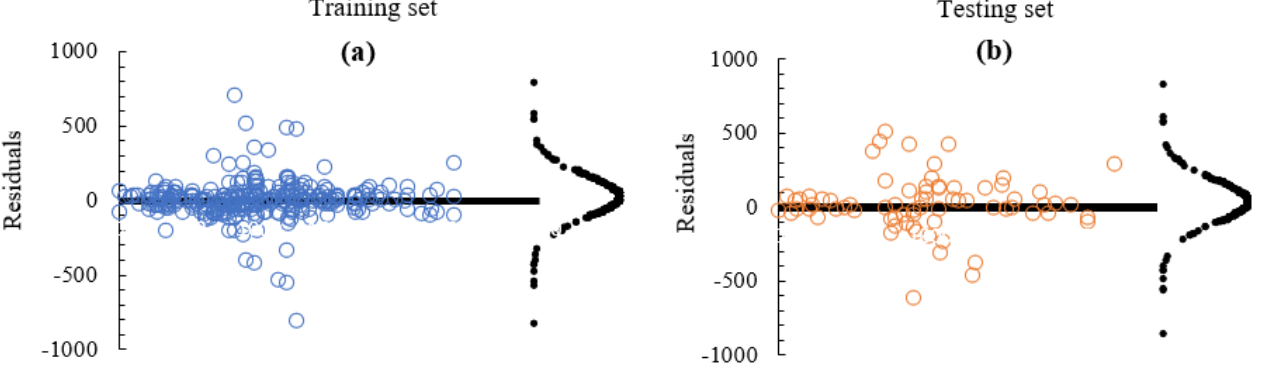
Figure 8. Residual curves. ( a ) Training set, ( b ) testing set.